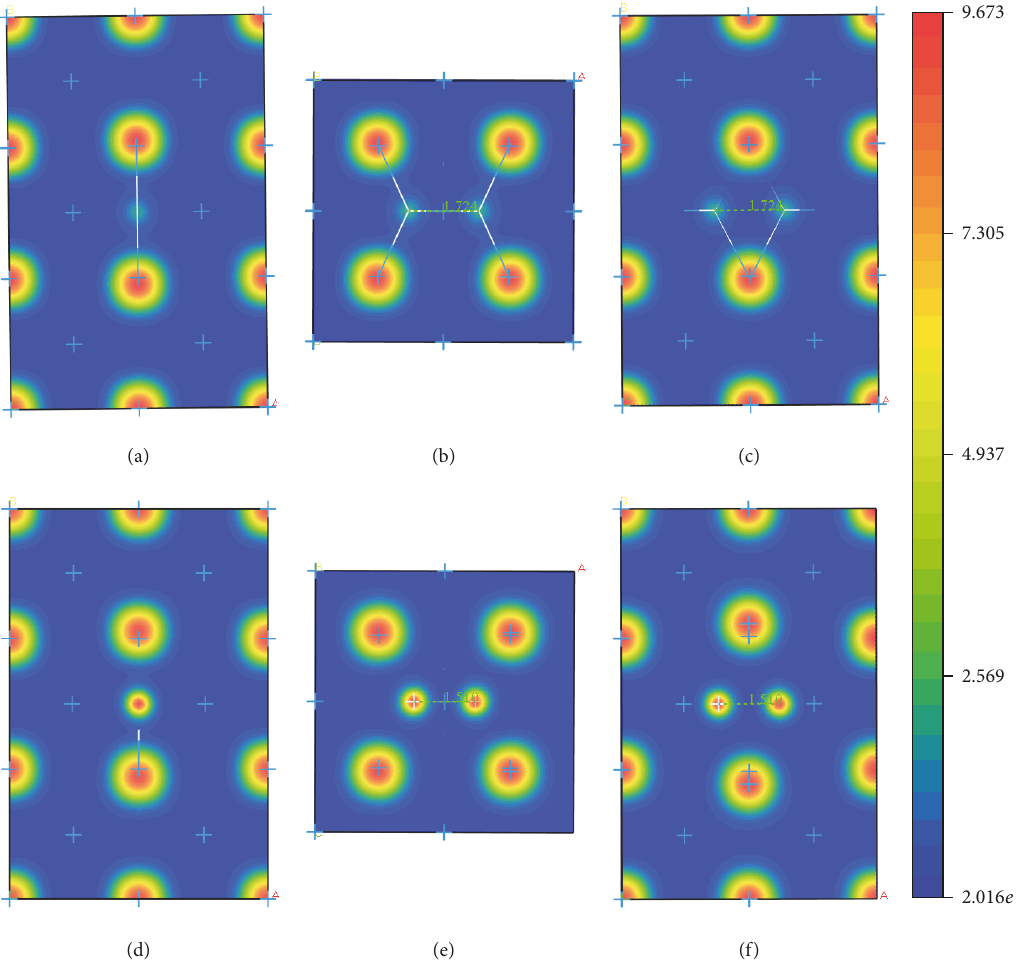
Figure 8: Charge density distribution. (a), (b), and (c) show the single H atom and two H atoms located in octahedral sites; (d), (e), and (f) show the single He atom and two He atoms located in different octahedral sites. The red color represents high charge density, and the blue color represents low valence charge